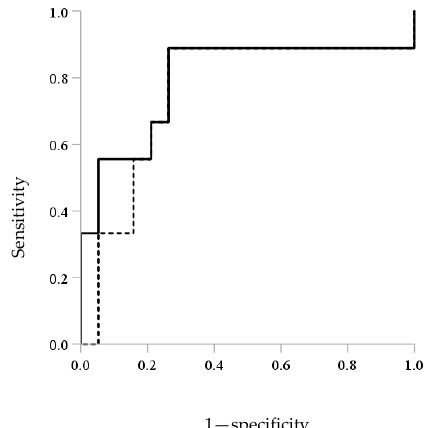
Figure 2. Receiver operator curve (ROC) analysis of the discrimination potential of AUC 0–24 (solid line) and C 0 (dashed line) of afatinib for the incidence of grade 2 diarrhea.